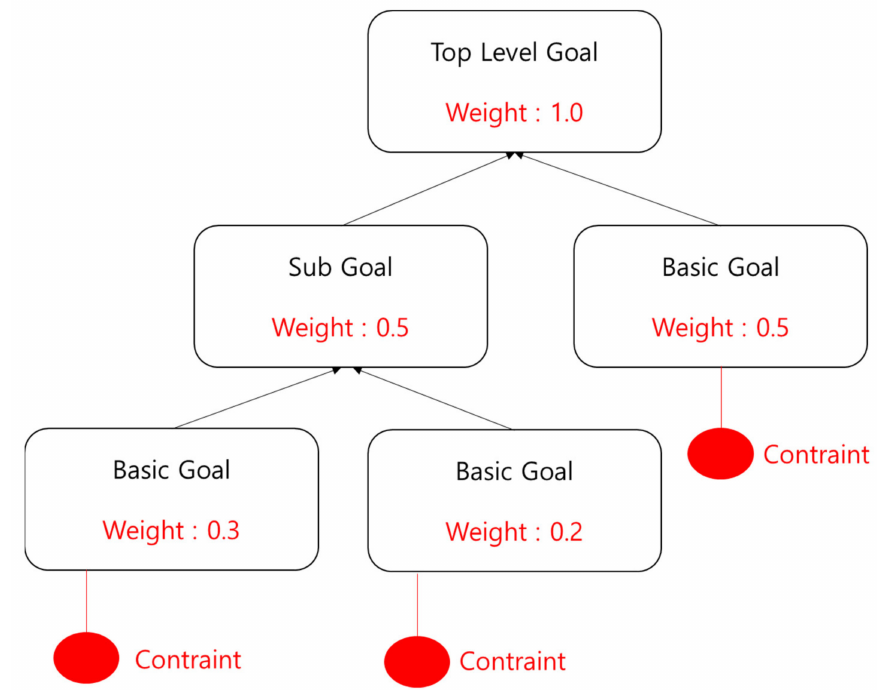
Figure 3. Goal model.